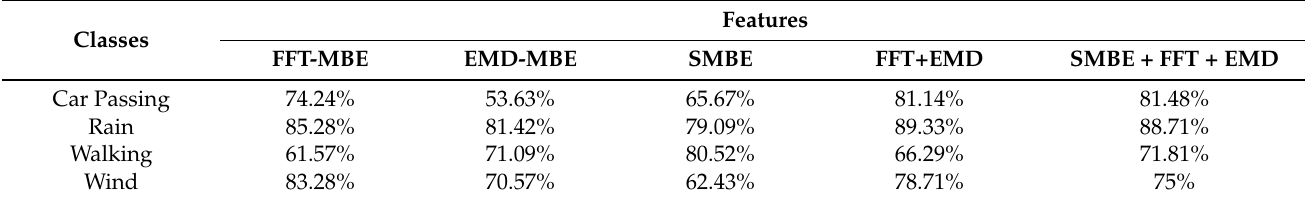
Table 6. Classification accuracy of each class for the custom